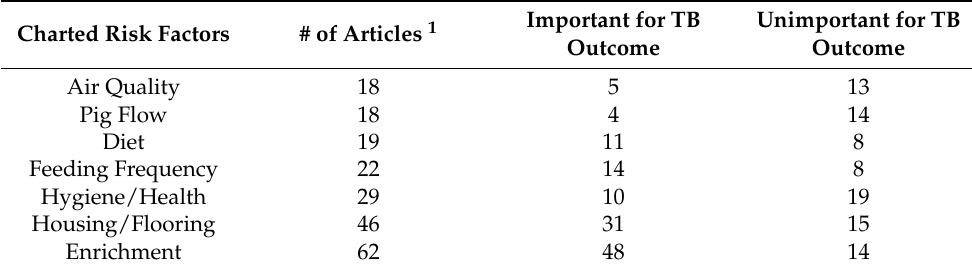
Table 5. Risk factors studied in the literature and the importance that was placed upon them in relation to controlling tail-biting (TB) successfully. Charted Risk Factors # of Articles 1